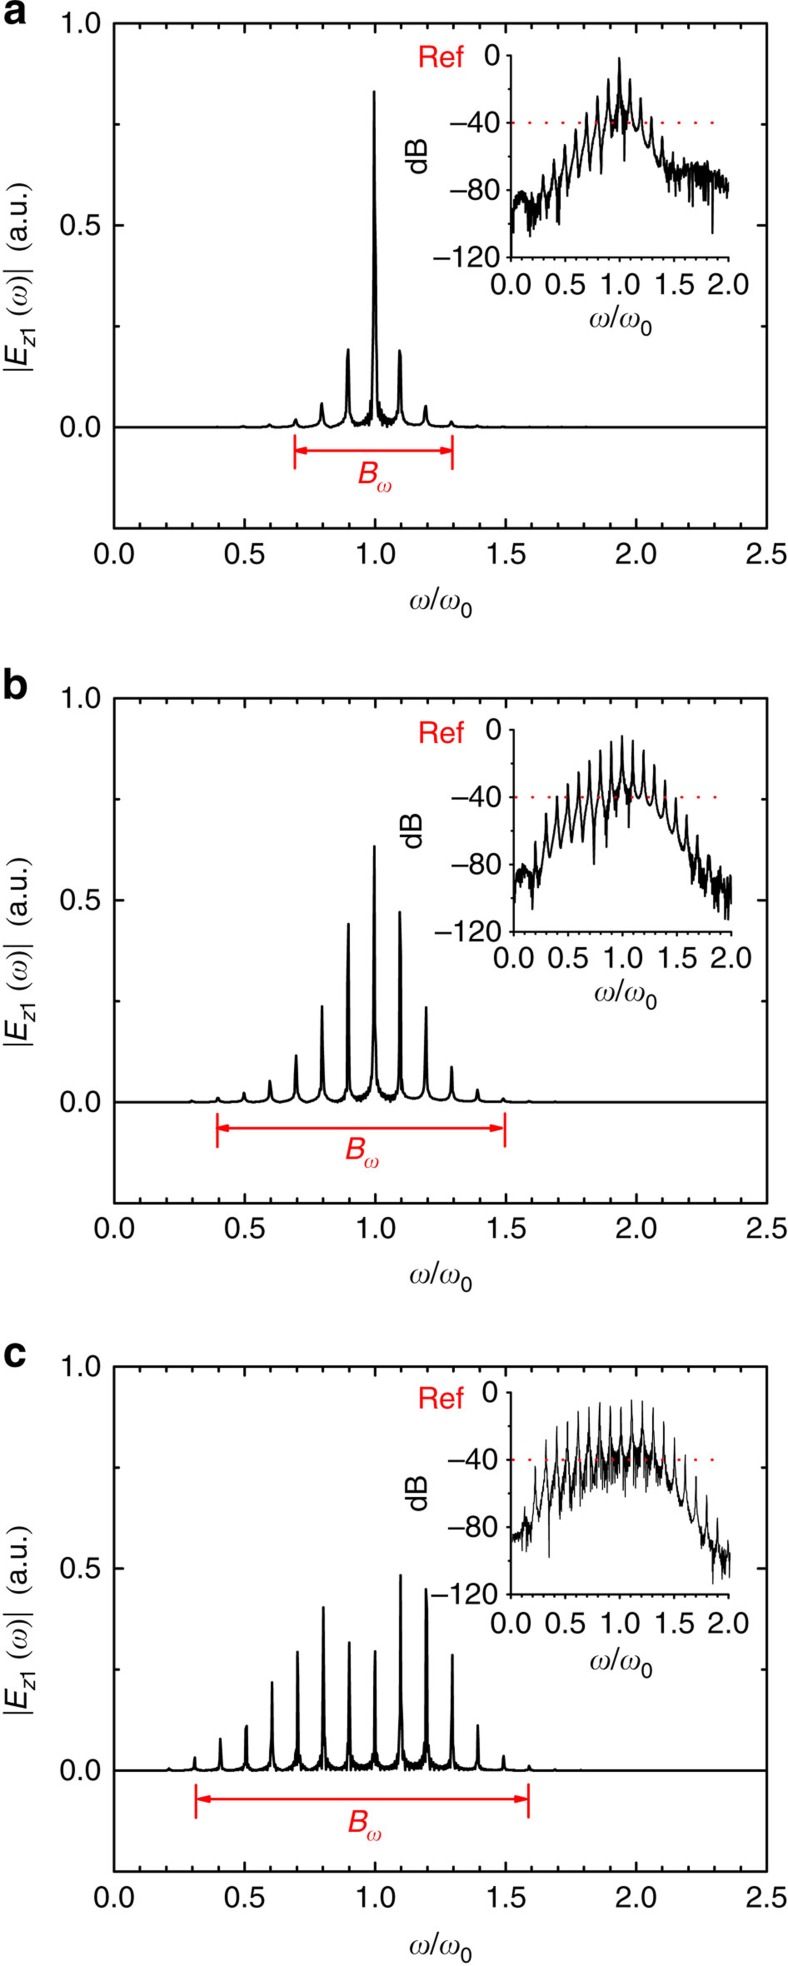
Evolution of the frequency spectrum of the carrier laser.The front of the carrier enters the plasma at t=50TL. (a,b,c) The spectra of the carrier at the propagation time of t=250TL, t=400TL and t=750TL (when the carrier completely passes through the plasma), respectively. TL=2π/ω0 is the laser cycle in vacuum. The insets in each plot show the spectra using logarithmic coordinates, with 0 dB the reference (that is, the unmodulated carrier) amplitude. See the laser–plasma simulation parameters in the Methods.